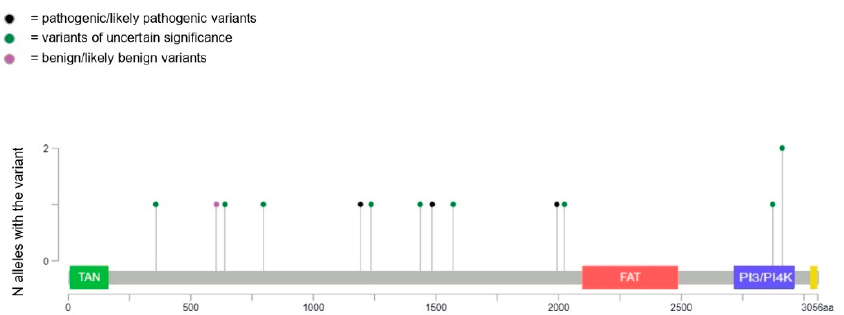
Figure 1. The lollipop plot shows the distribution of the ATM variants included in this study. TAN = Tel1/ATM N-terminal motif domain; FAT = FRAP–ATM–TRRAP domain; PI3/PI4K = phosphatidylinositol 3-kinase/phosphatidylinositol 4-kinase-related kinase domain. The p.Ser1135_Lys1192del and p.Ser1993ArgfsTer23 PV, as well as the